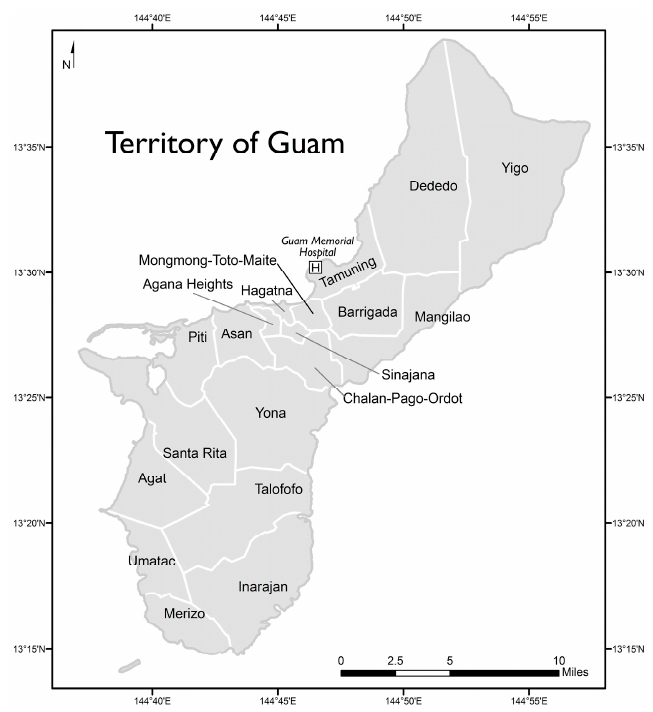
Figure 1. Territory of Guam with locations of study hospital and villages.